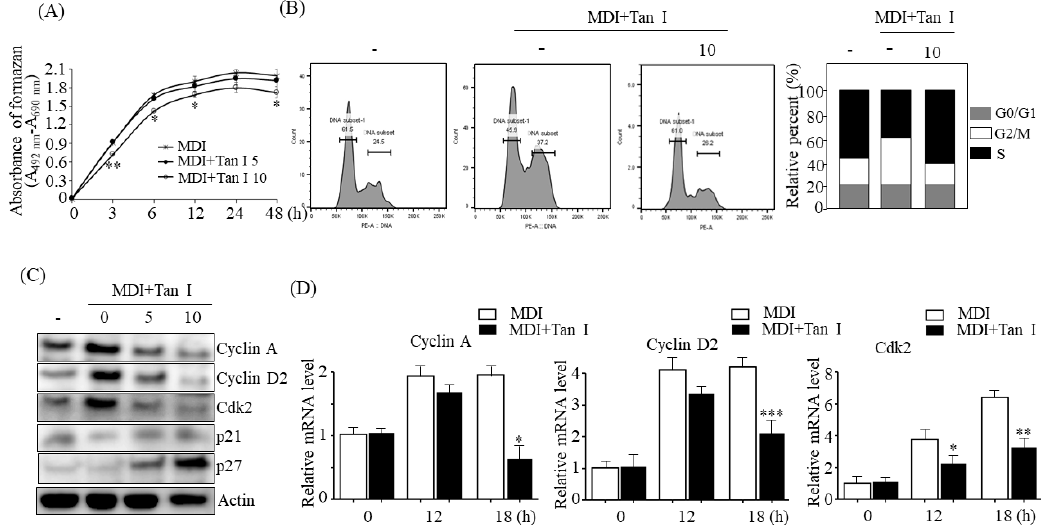
Figure 4. Tan I suppressed mitotic clonal expansion (MCE) during early adipogenesis. The 3T3-L1 preadipocytes were di ff erentiated in the MDI with 10 µ M Tan I for indicated times. ( A ) Cell numbers were measured at indicated times. ( B ) The cells were harvested with PI. The stained cells were analyzed by flow cytometer, and the cell population at each stage of the cell cycle was determined by BD Pro software. ( C ) The protein levels of cyclin A, cyclin D2, Cdk2, p21, and p27 were assessed by western blotting. The full length western blots are provided in Supplementary Figure S2. ( D ) The mRNA levels of cyclin A , cyclin D2 , and Cdk2 were measured by qPCR. The data are presented as the mean ± SEM of three replicate experiments. * p < 0.05, ** p < 0.01, *** p < 0.001 vs. di ff erentiated 3T3-L1 adipocytes without Tan I treatment. MDI means differentiation medium.